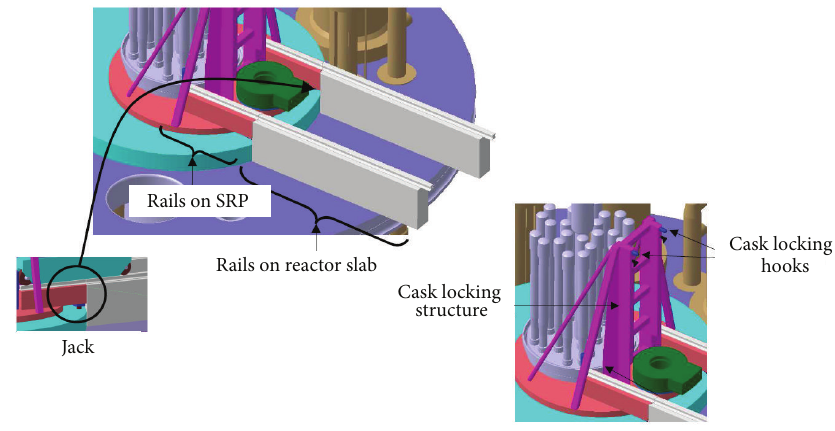
Figure 15: Details of the running rails and cask holding structure.